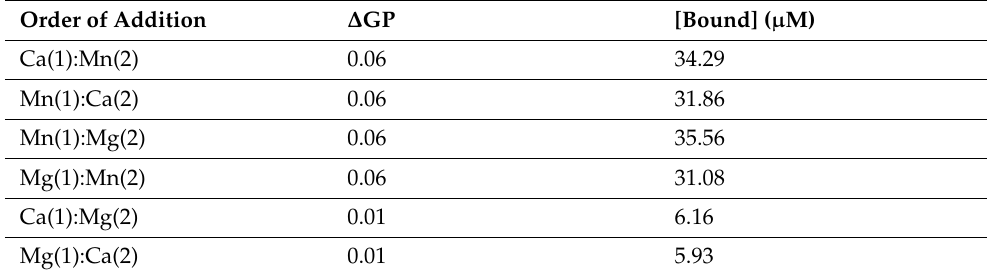
Table 2. Estimated bound metal fraction for sequential additions using Figure 1. Order of